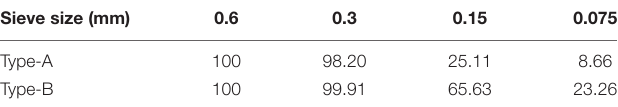
TABLE 4 | Size distributions of anti-icing additives (percent passing/%).